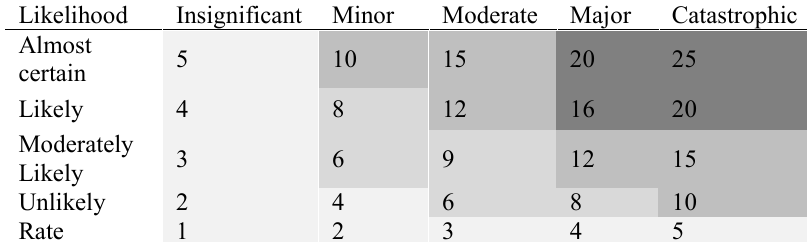
Table 1. Risk assessment Matrix 19